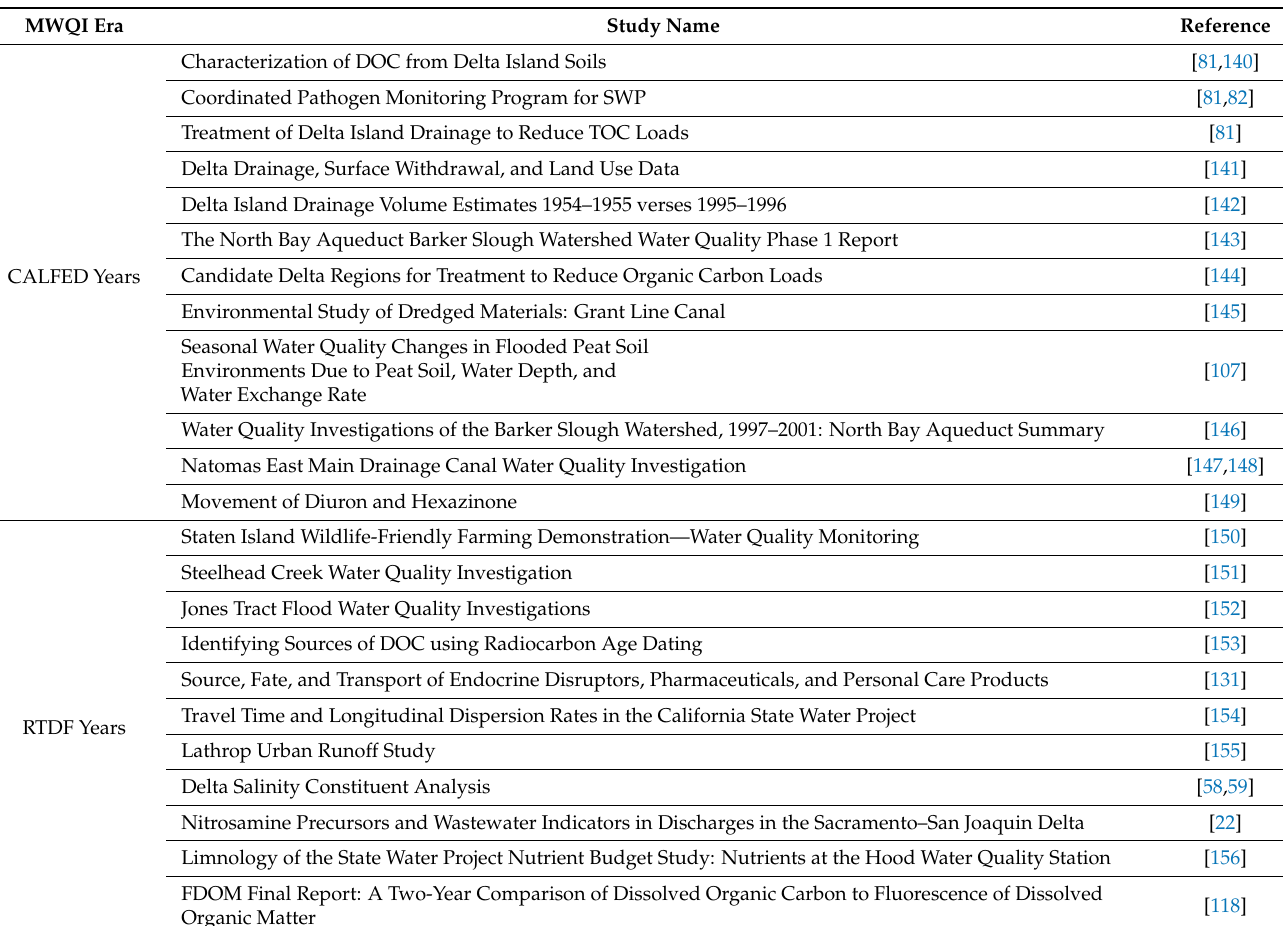
Figure A4. Sacramento River at Hood Real ‐ Time Monitoring Station. Table A2. Cross Section of Applied Science Studies Conducted under the MWQI